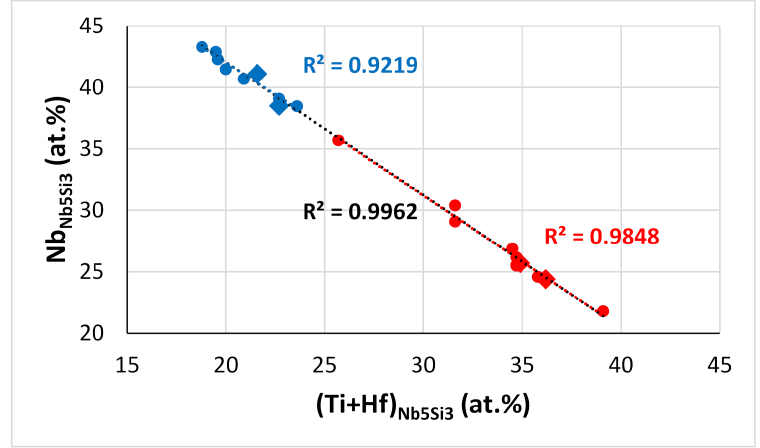
Figure 12. The Nb versus Ti + Hf map for the Nb 5 Si 3 in the alloys of this work. Blue data for “normal” Nb 5 Si 3 , red data for Hf-rich Nb 5 Si 3 . For all data R 2 = 0.9962. Diamonds for the RM(Nb)IC/RCCA alloy EZ8.